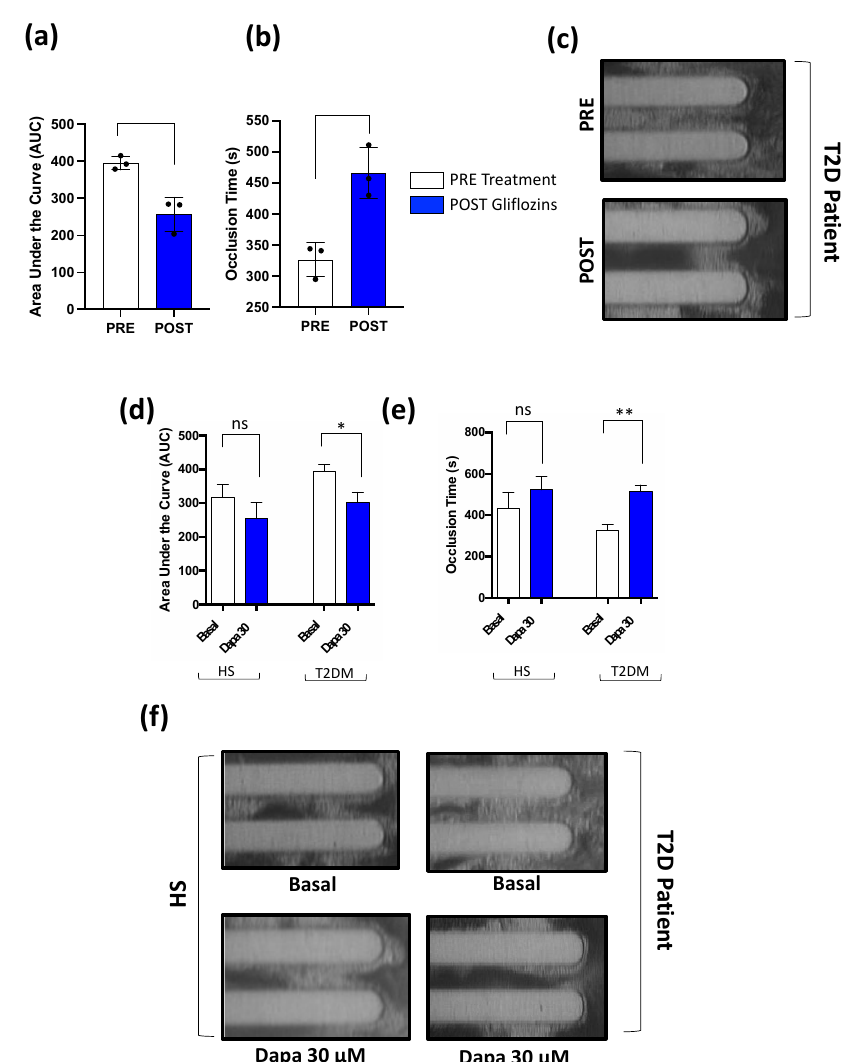
Figure 3. ( a – c ) In vivo effect of gliflozins therapy on platelet-dependent thrombus growth under laminar flow. Whole blood samples (T2D, n = 3) before treatment (PRE) and after 15 days of gliflozins therapy (POST). ( d – f ) In vitro effect of dapagliflozin (Dapa, 30 µ M) on platelet-dependent thrombus growth under laminar flow in whole blood samples taken from HS ( n = 3) and T2D patients ( n = 3). Samples were analyzed by ( a , d ), area under the curve (AUC), and ( b , e ) occlusion time; ( c , f ), representative images of thrombus formation under laminar flow conditions. Data were expressed as mean ± SD; * p < 0.05, ** p < 0.01; ns = not